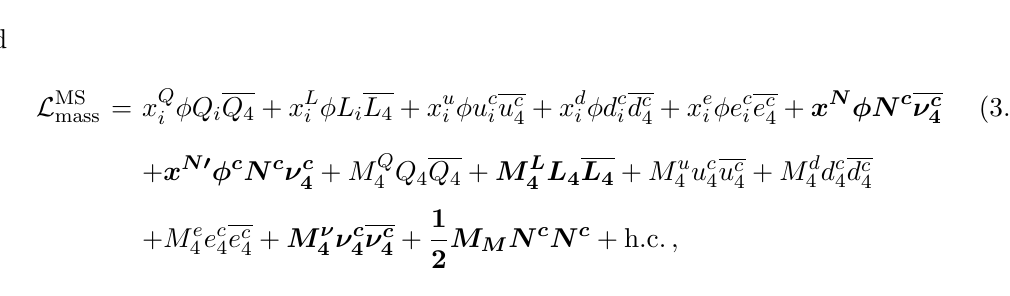
Figure 5 . Diagrams in the mass insertion approximation that generate the e(cid:11)ective Yukawa couplings that will contribute to the light neutrino